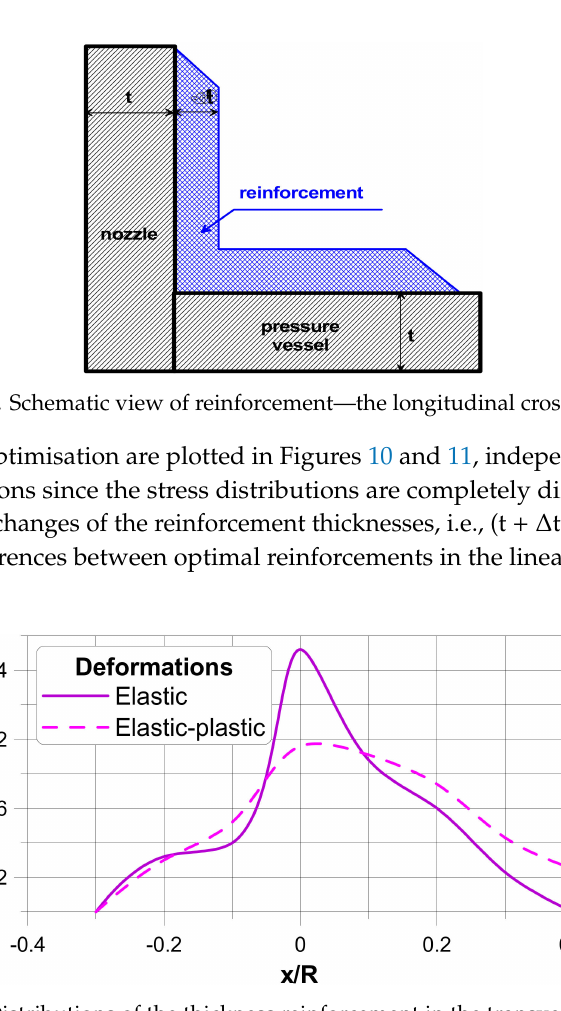
Figure 10. Distributions of the thickness reinforcement in the transverse direction.